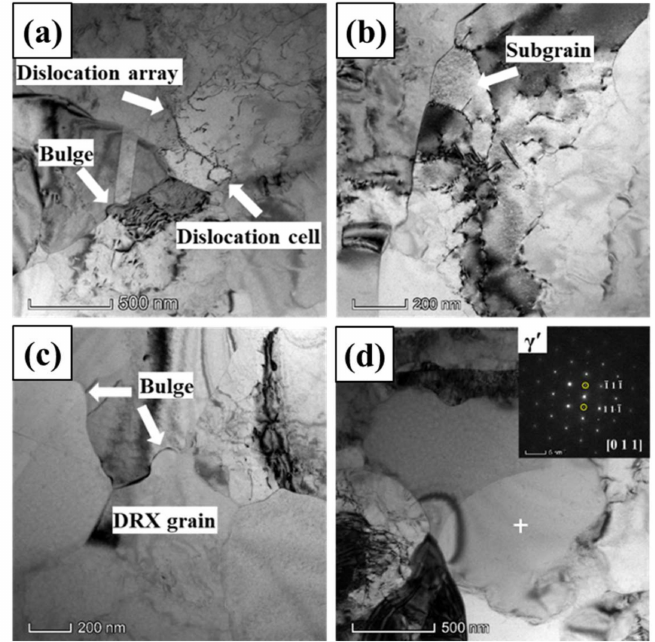
Figure 9. TEM morphology of GH4151 alloy after deformation at 1040 ◦ C, 0.1 s − 1 and strain of 0.5: ( a ) Bulge and dislocations; ( b ) Subgrain; ( c ) Bulge and DRX grain; ( d ) DRX